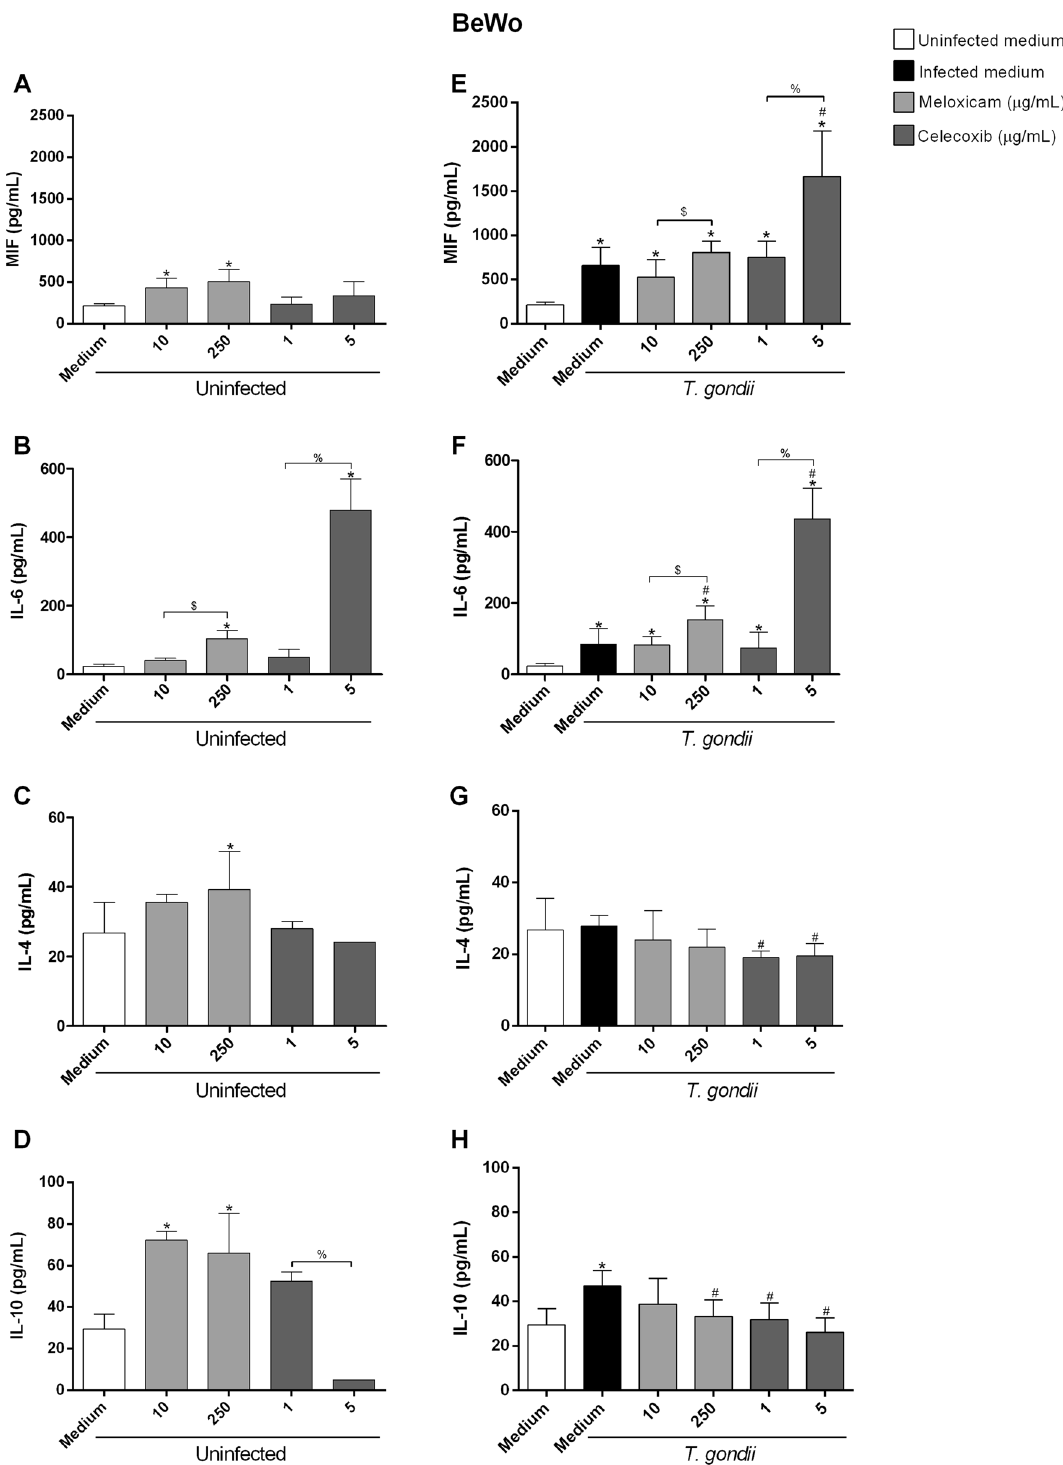
Figure 3. Cytokines production in BeWo cells infected and treated with COX-2 inhibitors. BeWo cells were infected or not with T. gondii for 3 h and treated or not with meloxicam or celecoxib for an additional 24 h. Next, the supernatants were collected for measurement of MIF ( A , E ), IL-6 ( B , F ), IL-4 ( C , G ) and IL-10 ( D , H ) by ELISA. Data were shown as mean ± SEM from three independents experiments with eight replicates. Differences between groups were analyzed by One-Way ANOVA test with Sidak’s multiple comparison ( A , B , E , F ) or Kruskal–Wallis test and Dunn’s multiple comparison post-test ( C , D , G , H ) (GraphPad Prism Sofware version 6.01, https:// www. graph pad. com). Significant differences in relation to untreated and uninfected cells ( * uninfected medium), untreated and infected cells ( # infected medium), between concentrations of meloxicam ( $ ) or celecoxib ( % ), regardless of infection. Differences were considered significant when P <